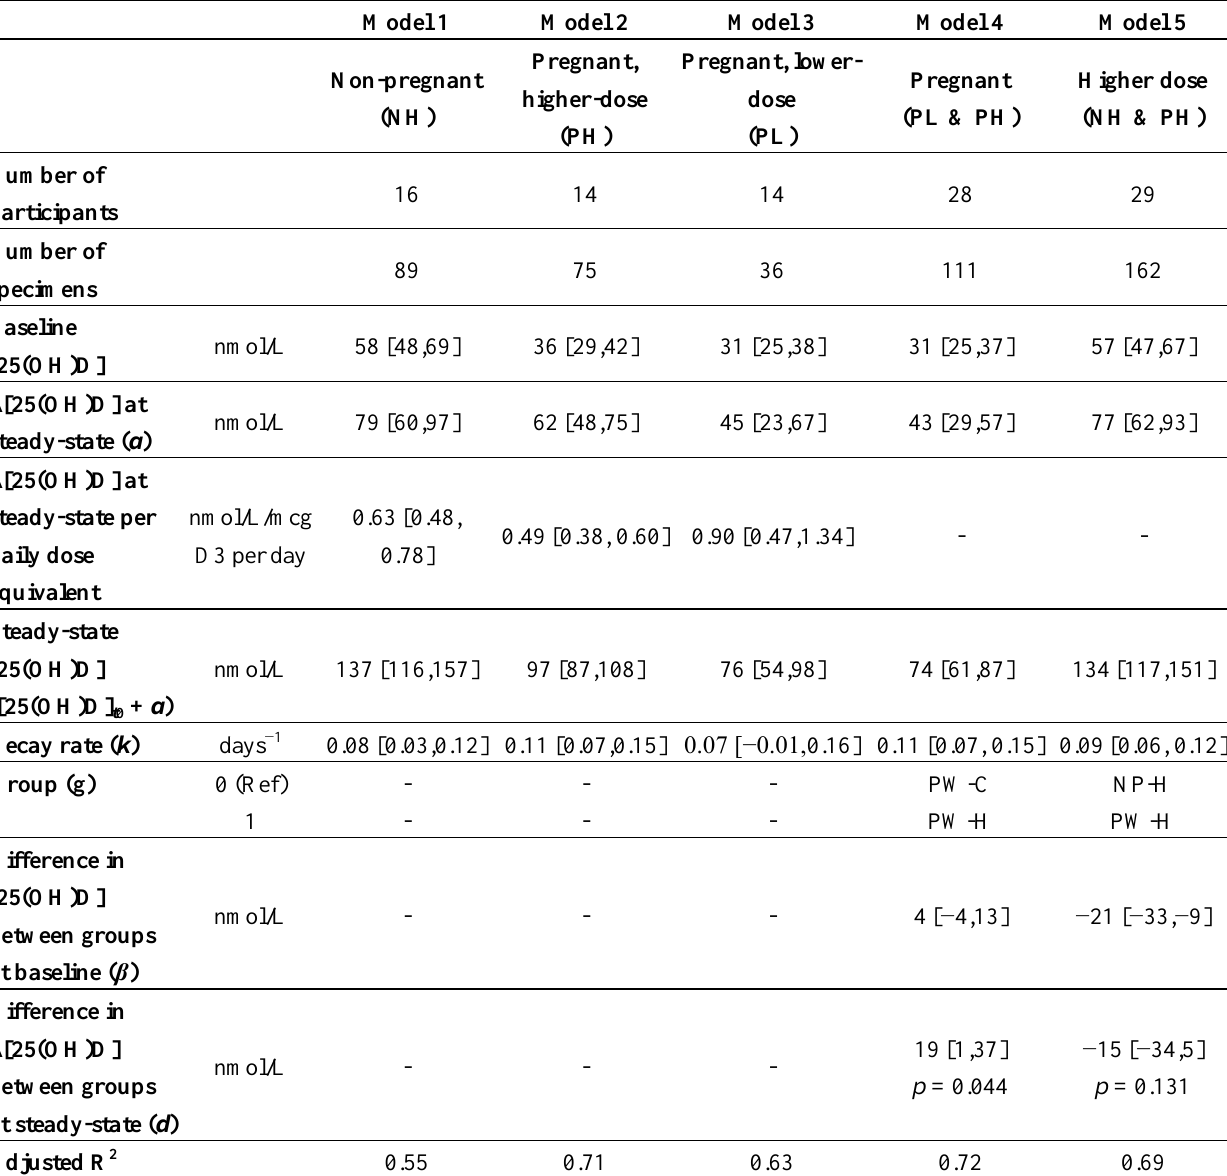
Table 3. Estimates of the change in serum 25-hydroxyvitamin D concentration over time in response to weekly vitamin D3 supplementation in non-pregnant women who received an initial dose of 70,000 IU and then 35,000 IU/week (NH), pregnant women who received an initial dose of 70,000 IU and then 35,000 IU/week (PH), and pregnant women who received a weekly dose of 14,000 IU/week (PL). Results are based on negative exponential models, and shown as mean (lower 95% confidence bound, upper 95% confidence